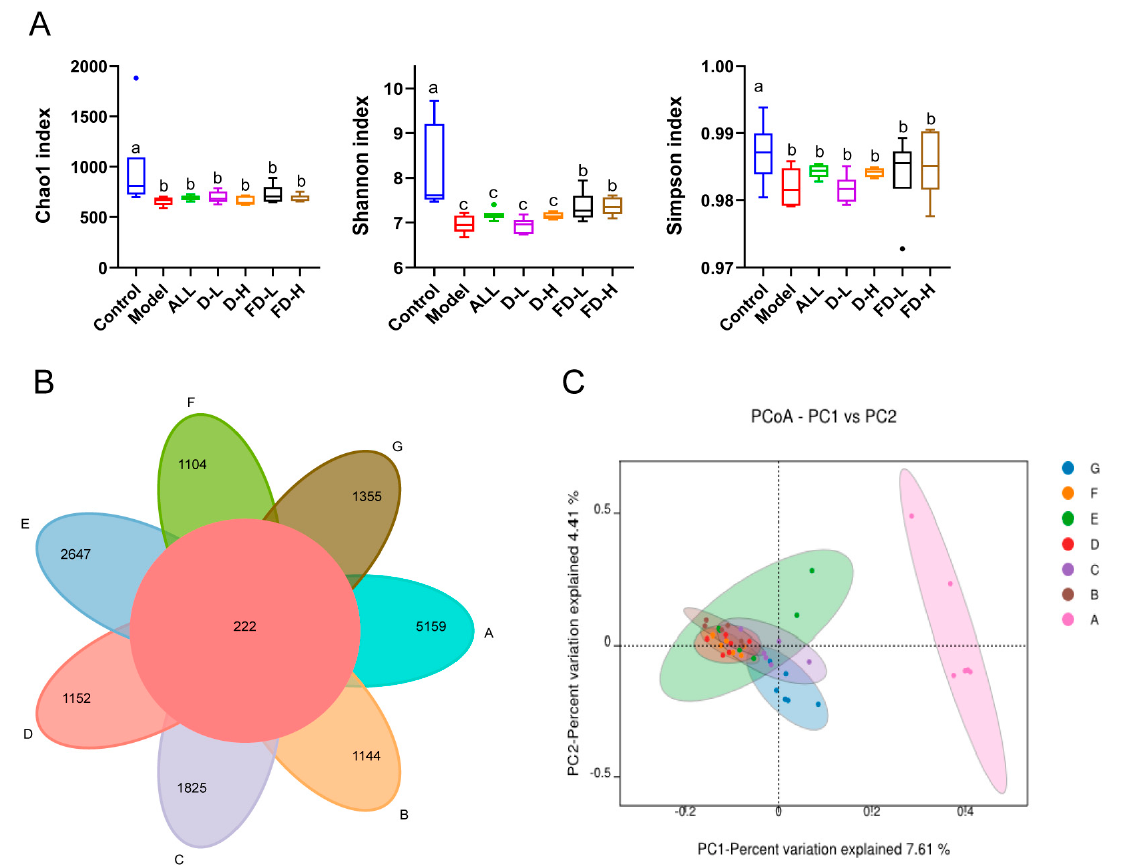
Figure 7. E ff ects of fermented dandelion on intestinal micro fl ora diversity in mice with HUA. ( A )Al- Figure 7. Effects of fermented dandelion on intestinal microflora diversity in mice with HUA. pha diversity analysis; ( B )Venn; ( C )PCoA. The data are expressed as mean ± SD (n = 6). Di ff erent ( A ) Alpha diversity analysis; ( B ) Venn; ( C ) PCoA. The data are expressed as mean ± SD (n = 6). Different lowercase letters indicate statistically significant differences ( p < 0.05) between the